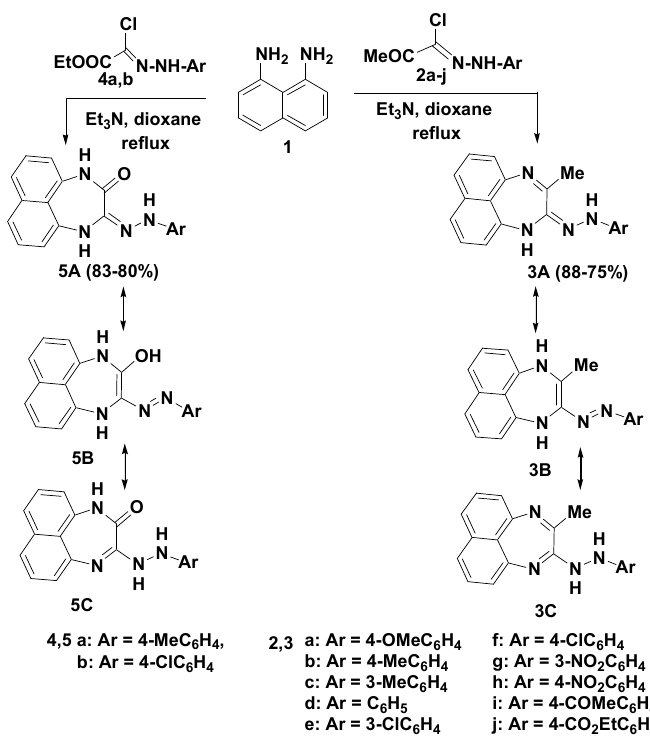
Table 1. UV Spectral data of compounds 3a – j , 5a , b and 11a – h in dioxane. Compd.